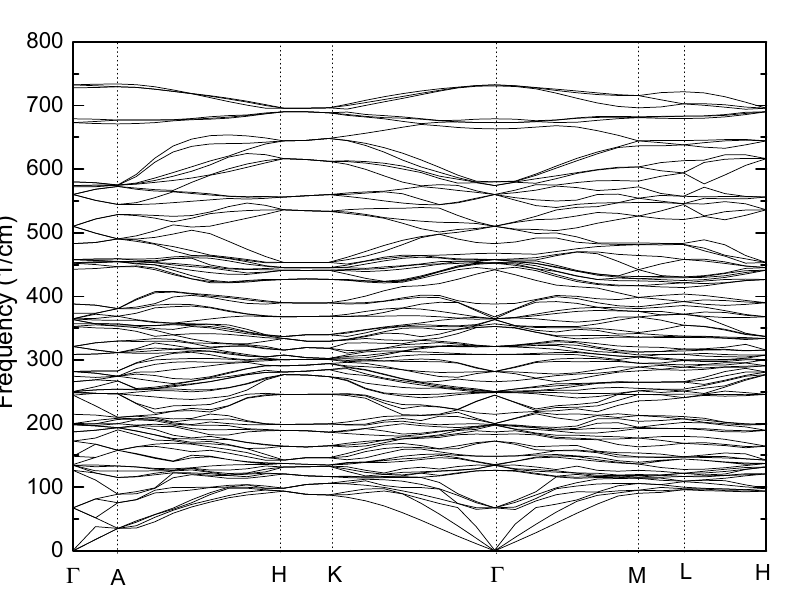
Figure 6. The phonon dispersion relations of the ilmenite (IL)-type ZnTiO 3 (space group R 3 ) along high symmetry directions based on